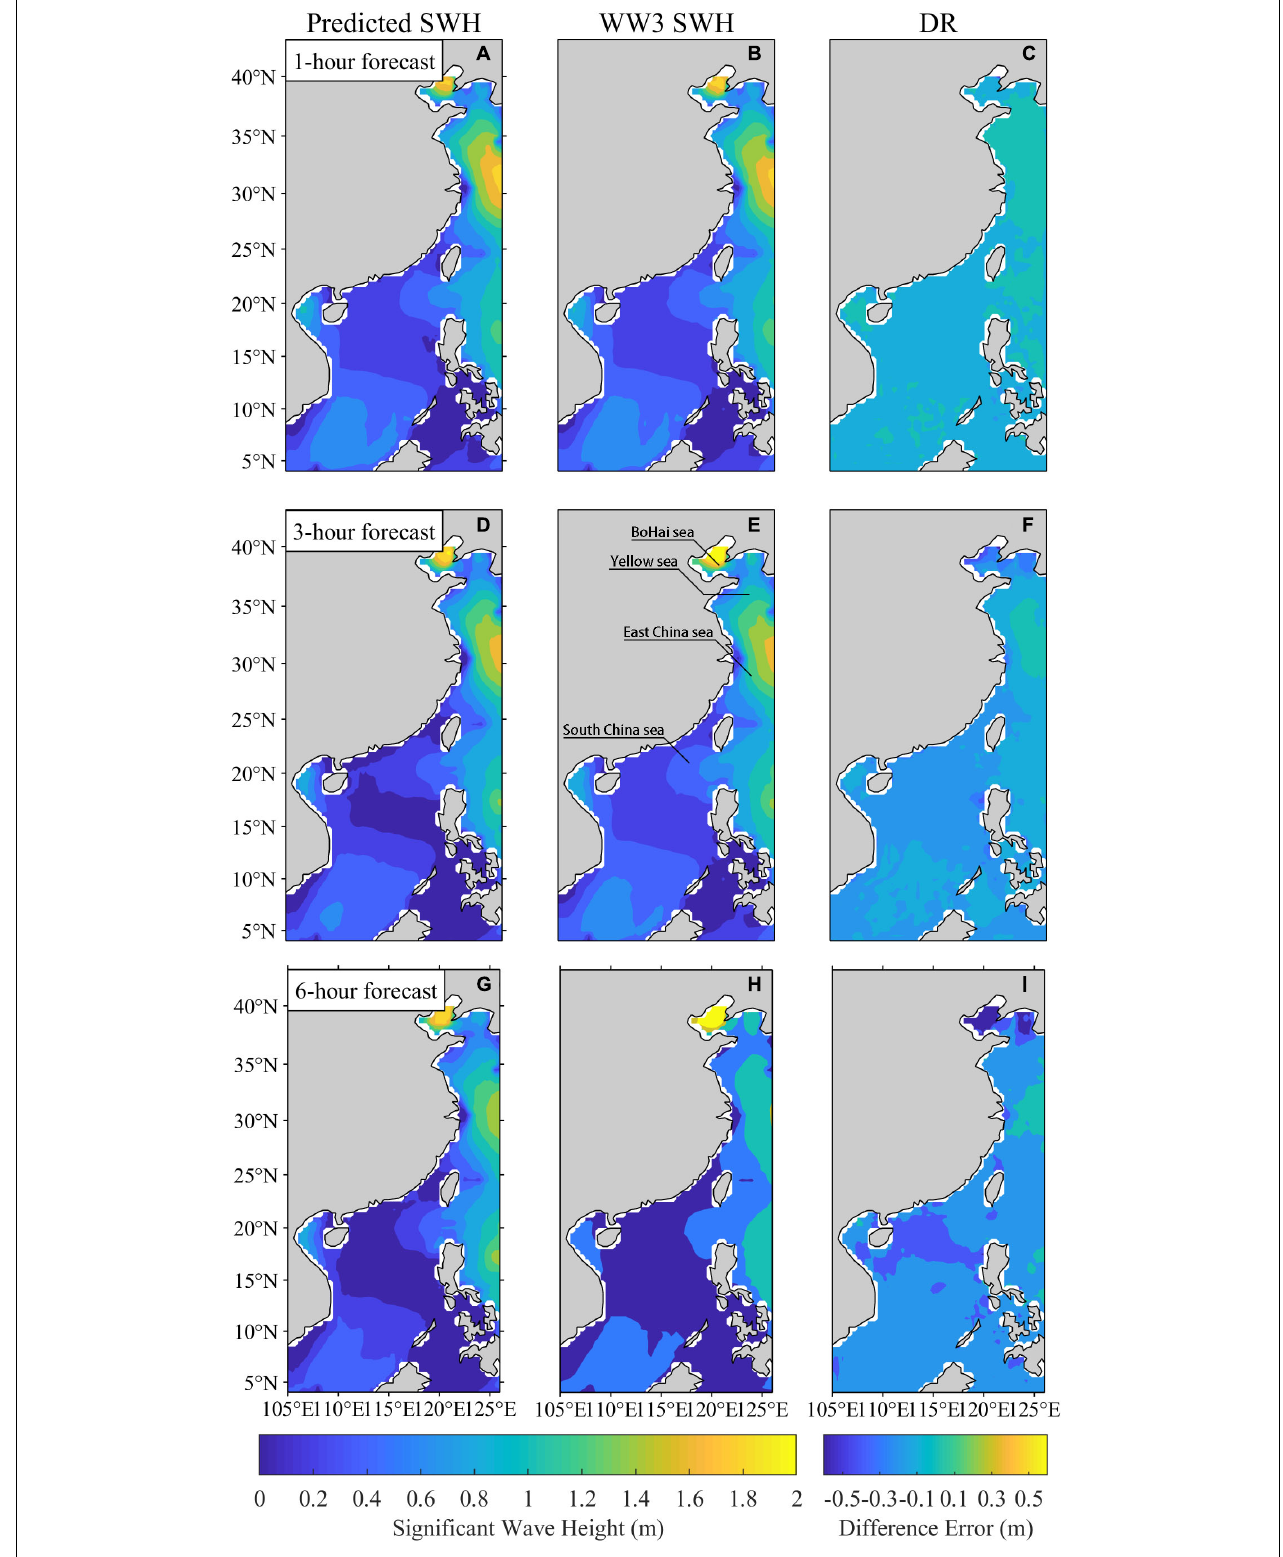
FIGURE 2 | Comparison of SWH from the WW3 and the ConvLSTM algorithm prediction. (A , D,G) are 1-, 3-, and 6-h predictions, respectively, based on the SWH data at 5:00, 6:00, and 7:00 on October 3, 2019. (B , E , H) The WW3 wave fields at the corresponding forecast moments. (C,F,I) are the difference error between the WW3 data and the